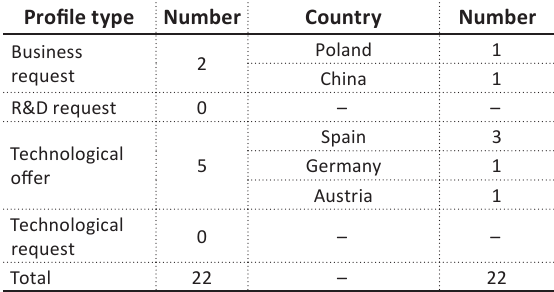
Table 8. Analysis of cooperation in the context of Ukraine in subsectors “Computer graphics” and “3D” for the first half of 2019